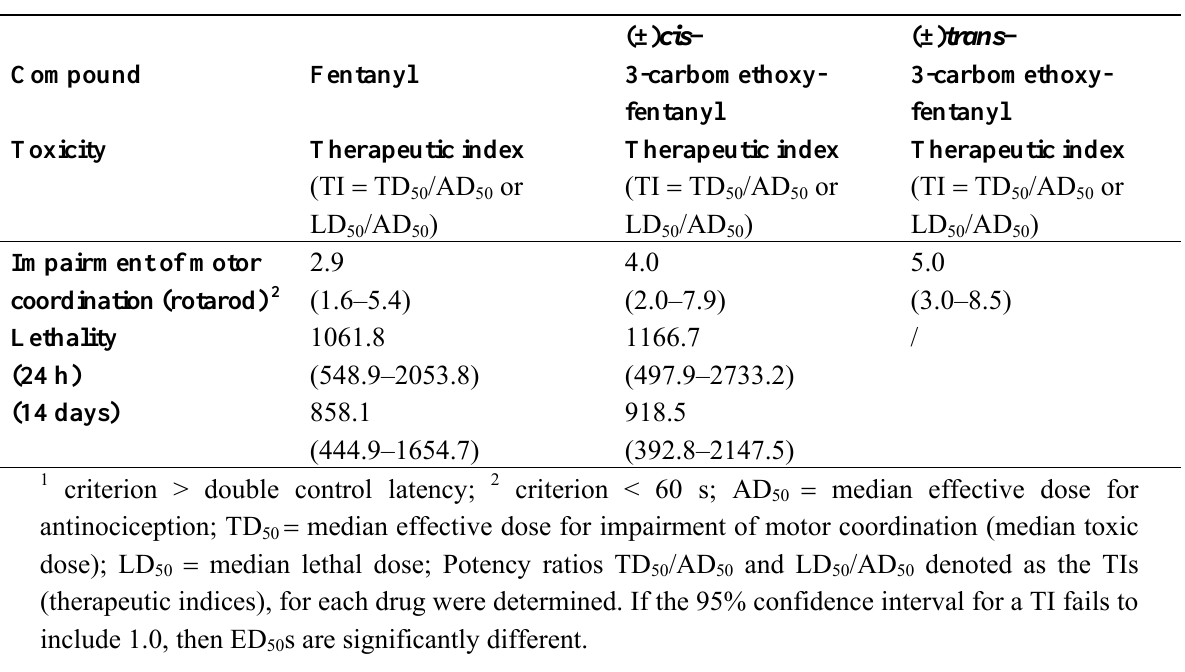
Table 2 . Therapeutic indices for fentanyl, (±) cis 3-carbomethoxy fentanyl and (±) trans 3- carbomethoxy fentanyl in